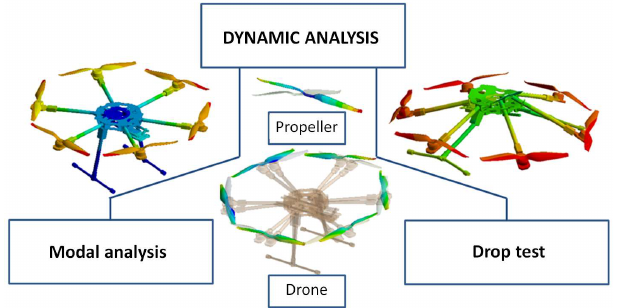
Figure 40. Hexacopter dynamic analysis using FEM.